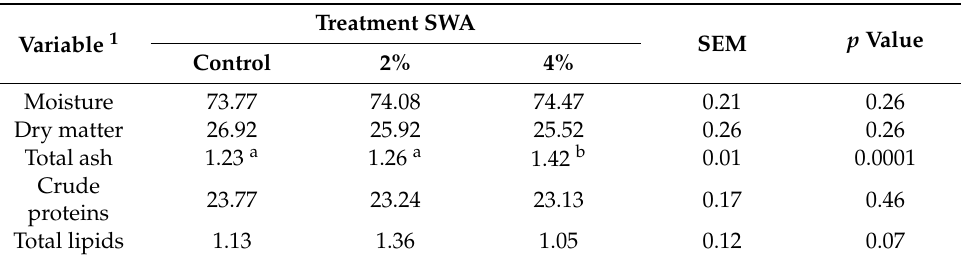
Table 3. Effects of the inclusion of seaweed additive (SWA) in the diet of fattening pigs on the proximate composition of pork meat.